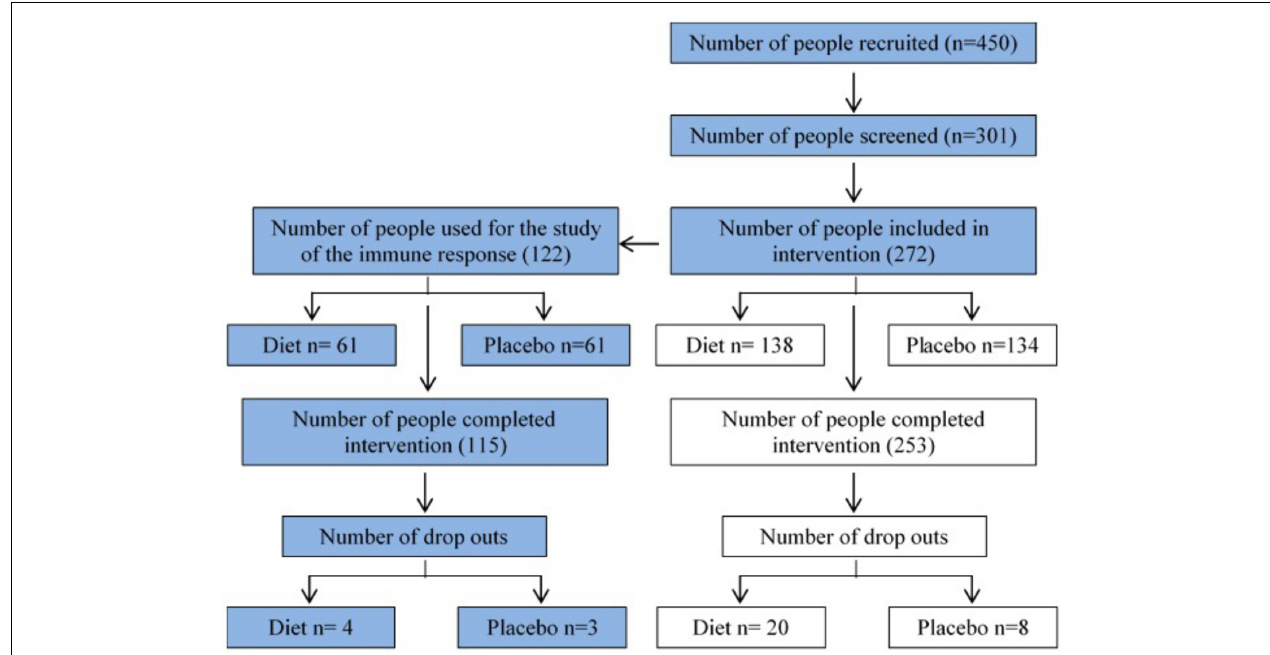
FIGURE 1 | Flow chart summarizing recruitment and retention of study participants. 272 volunteers were recruited at baseline in the NU-AGE English (Norwich) cohort (134 control, 138 MedDiet) for the dietary intervention. This study (blue boxes) focuses on the effects of dietary intervention on a variety of parameters of the immune responses.